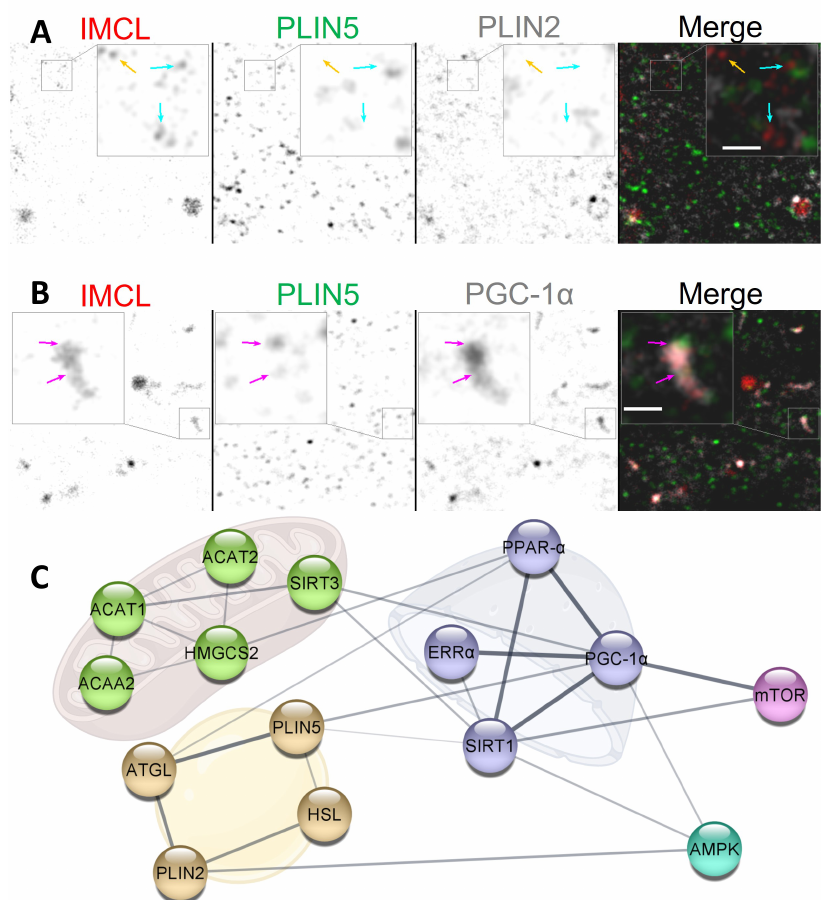
Figure 7. Potential dynamics between IMCL, PLINs and PGC-1 α . ( A ) dissociating cytosolic PLIN2. Note that IMCL aggregates with no PLIN2 associated (cyan arrows) and with no PLIN association whatsoever (orange arrow); ( B ) cytosolic association of IMCL-PLIN5-PGC-1 α . Note occasional but extensive association between IMCL and PGC-1 α , often colocalizing with PLIN5 (magenta arrows). Gray is signal. Bars in ( A , B ) = 500 nm; ( C ) physical interaction network from STRING databases. Golden cluster are LD proteins. Green clusters are mitochondrial enzymes involved in BCAA degradation and cholesterol biosynthesis. Purple clusters are nuclear proteins involved in transcription. Cyan positively responds to exercise. Pink positively responds to BCAA availability. Line thickness indicates the strength of data support. See the end of document for